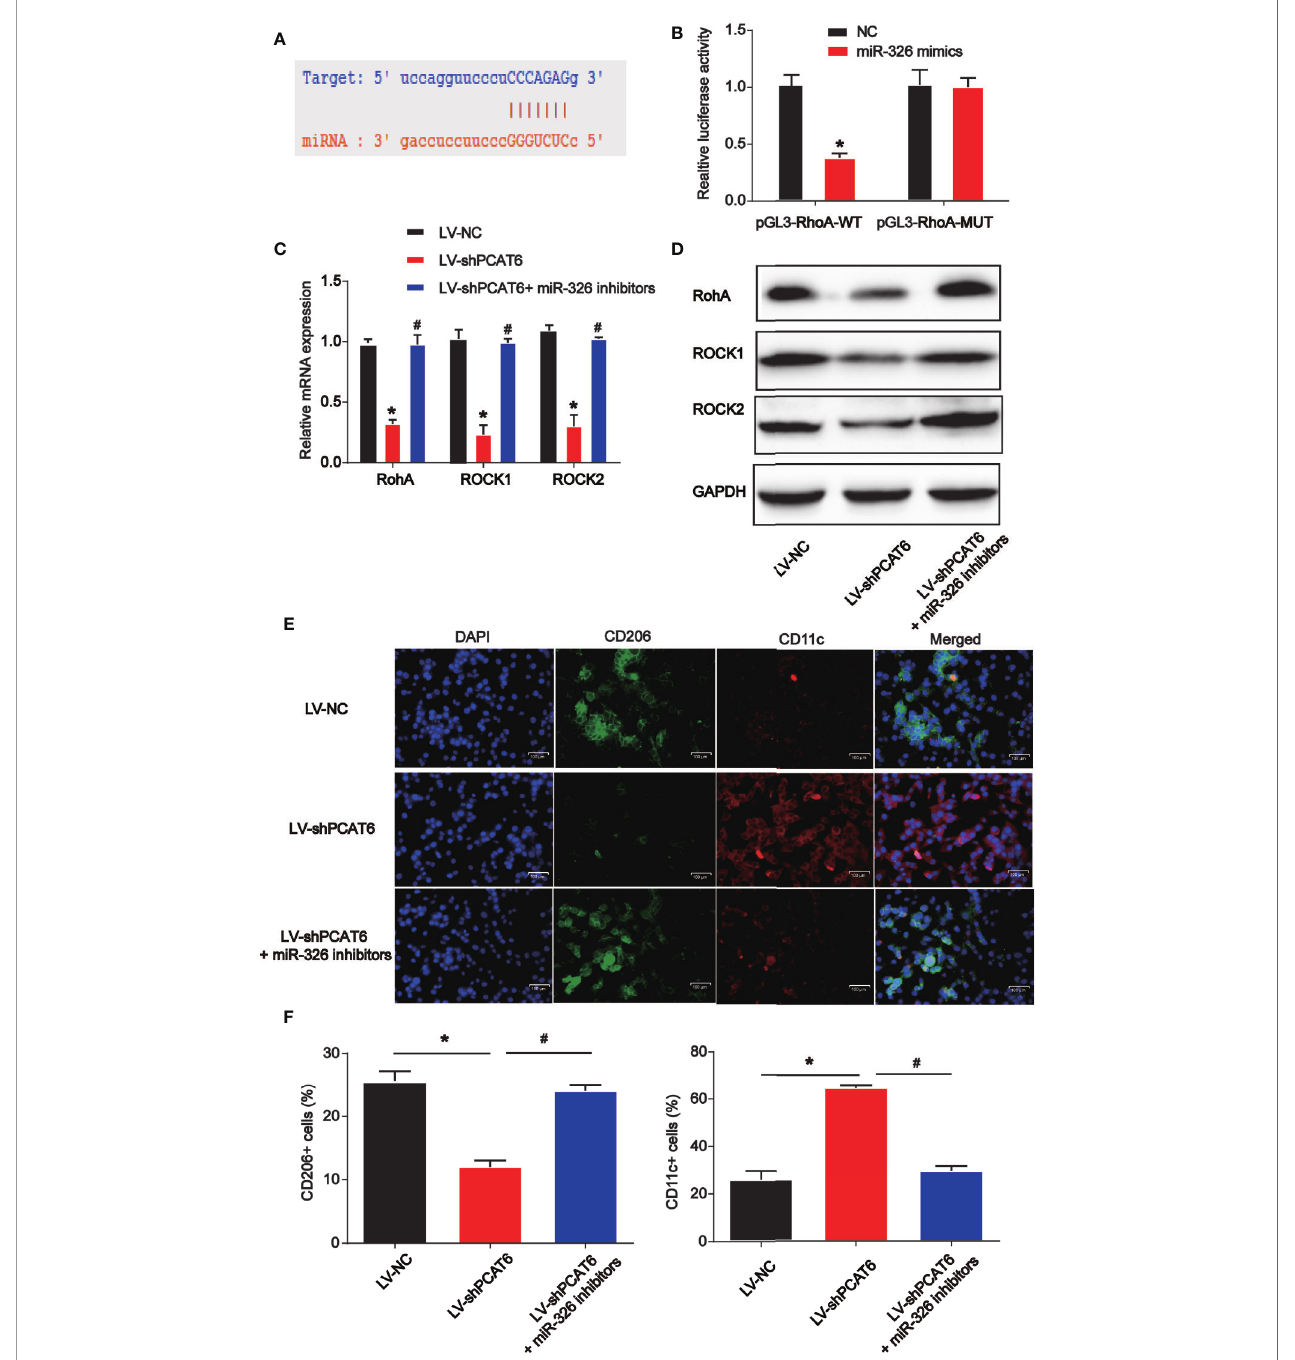
FIGURE 7 | RhoA was a direct target of miR-326. (A) The putative binding sites between RhoA and miR-326. (B) Luciferase activity was evaluated in THP-1- diferentiated macrophages co-transfected with RhoA-WT or RhoA-MUT reporter and miR-326 mimics. (C, D) RhoA, ROCK1, and ROCK2 expression in THP-1- diferentiated macrophages transfected with PCAT6 short hairpin RNA (shRNA) and miR-326 inhibitors. (E, F) Immuno fl uorescence with M2 marker (CD206) and M1 marker (CD11b) was carried out. Scale bar, 100 m m. *P < 0.05. Compared with the control group. # P < 0.05. Compared with LV-shPCAT6 staining intensity of PCAT6-upregulated THP-1-diferentiated control THP-1-diferentiated macrophages s, which was reversed macrophages was signi fi cantly induced than the control THP-1- by miR-326 mimics ( Figure 6A ). Furthermore, the DHE was differentiated macrophages ( Figure 6B ). The oxygen uptake was used to detect the ROS levels in vitro . As shown, the DHE